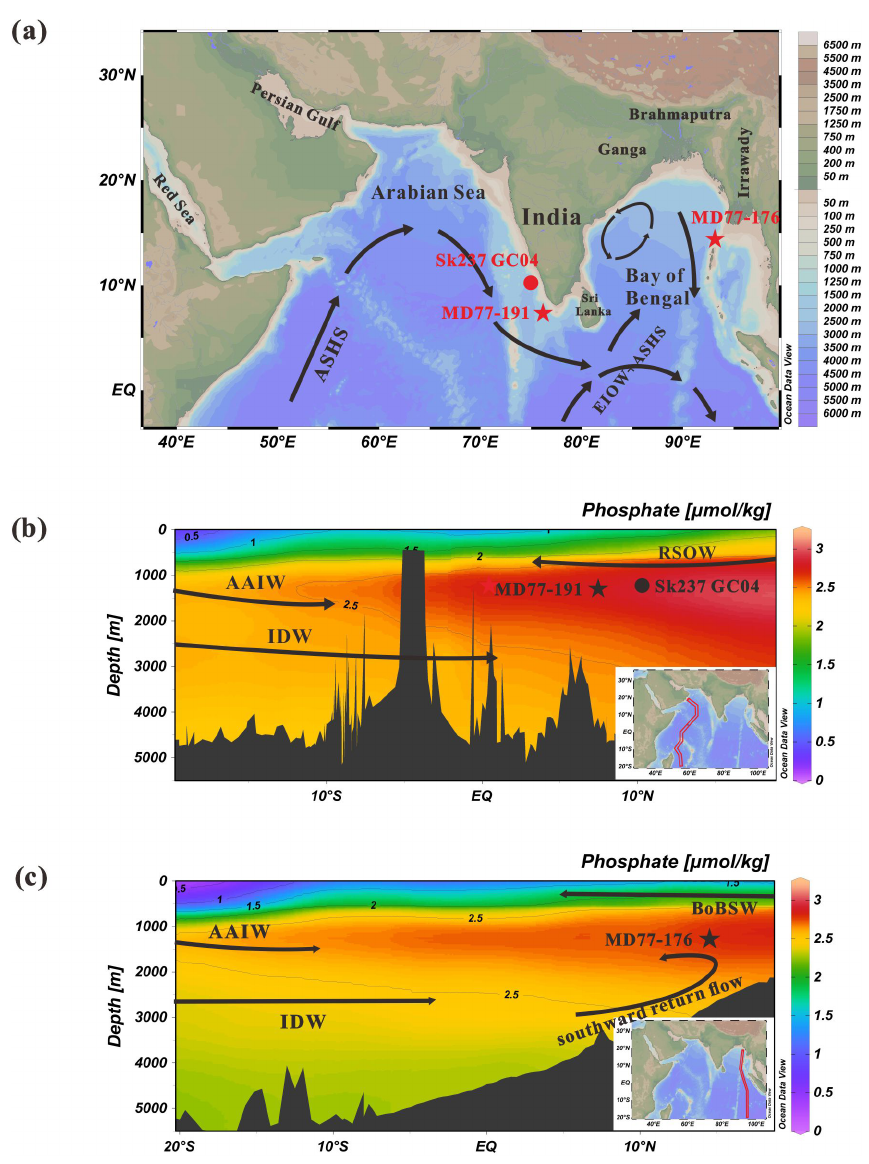
Figure 1. (a) Oceanographic setting and locations of core MD77-191 in the Arabian Sea (red star), core MD77-176 in the Bay of Bengal (red star) and reference site SK237 GC04 (red circle, Naik et al., 2017). The black arrows represent the general surface circulation direction in the northern Indian Ocean during the summer southwest monsoon (Schott and McCreary, 2001). (b, c) Phosphate distribution along depth– latitude sections during the southwest monsoon and northeast monsoon periods, for the Arabian Sea and the Bay of Bengal, respectively. Data (in µmolkg − 1 , colored scale; Schlitzer, 2000) were contoured and plotted using the Ocean Data View (ODV) software (Schlitzer, 2015). On these two figures are shown the distribution and circulation of water masses in the Arabian Sea and Bay of Bengal (black arrows). ASHS: Arabian Sea High Salinity Water; EIOW: Eastern Indian Ocean Water; BoBSW: Bay of Bengal surface waters; AAIW: Antarctic Intermediate Water; RSOW: Red Sea Overflow Water; IDW: Indian Deep